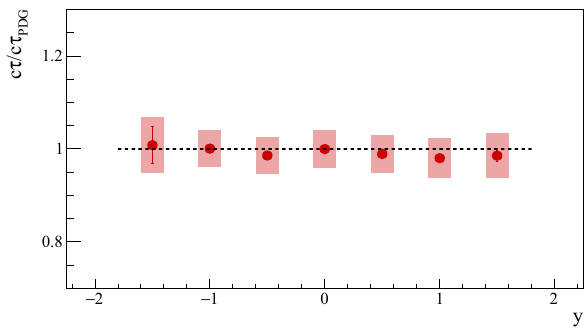
Fig. 8 Mean lifetime obtained from fits to the lifetime distributions of Fig. 7 with statistical (vertical bars) and systematic (shaded boxes) uncertainties versus the rapidity y